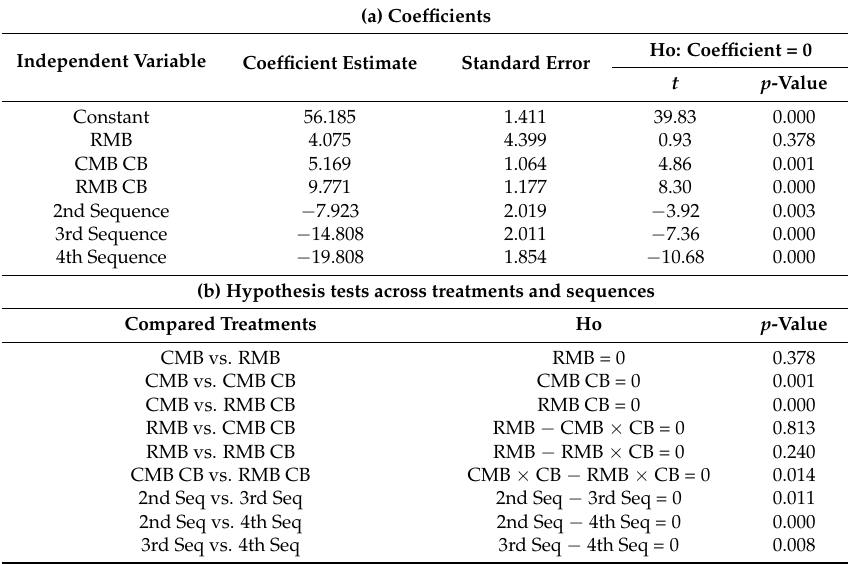
Table 3. OLS Regression with Robust Clustered Standard Errors. Dependent Variable: Total Group Contribution to the Group